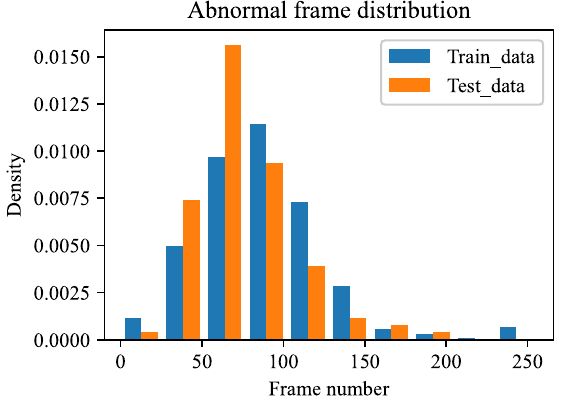
Figure 8. The statistical distribution of the number of frames of the samples with